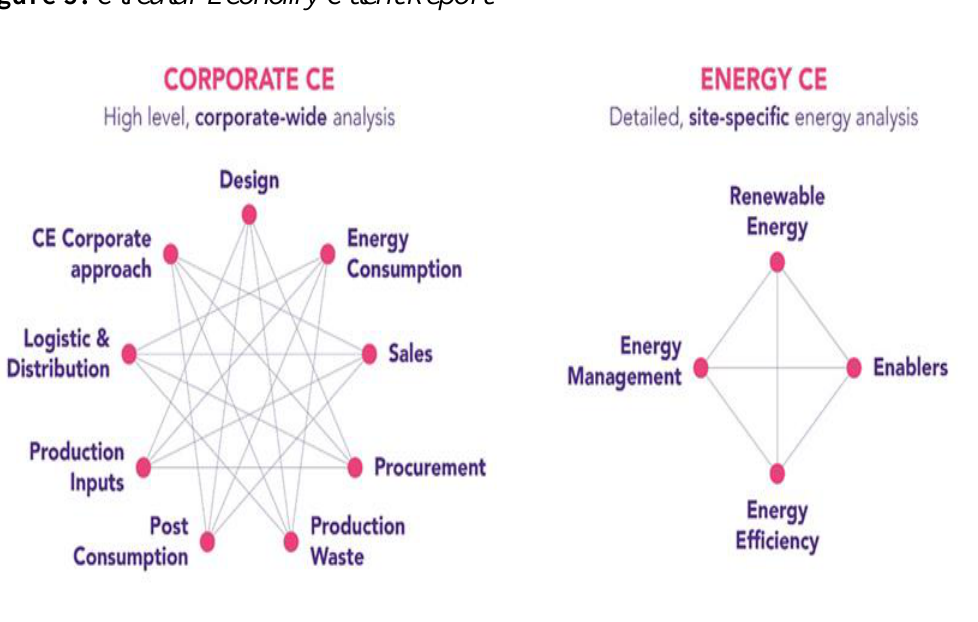
Figure 5: Circular Economy Client